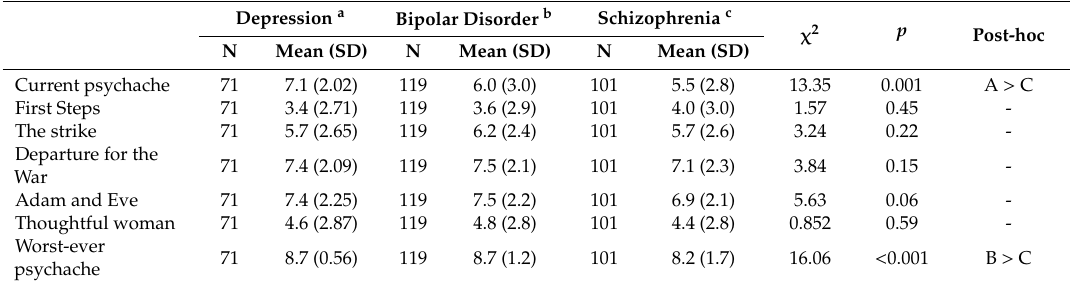
Table 4. Psychache scale by diagnosis Kruskal-Wallis Rank Sum